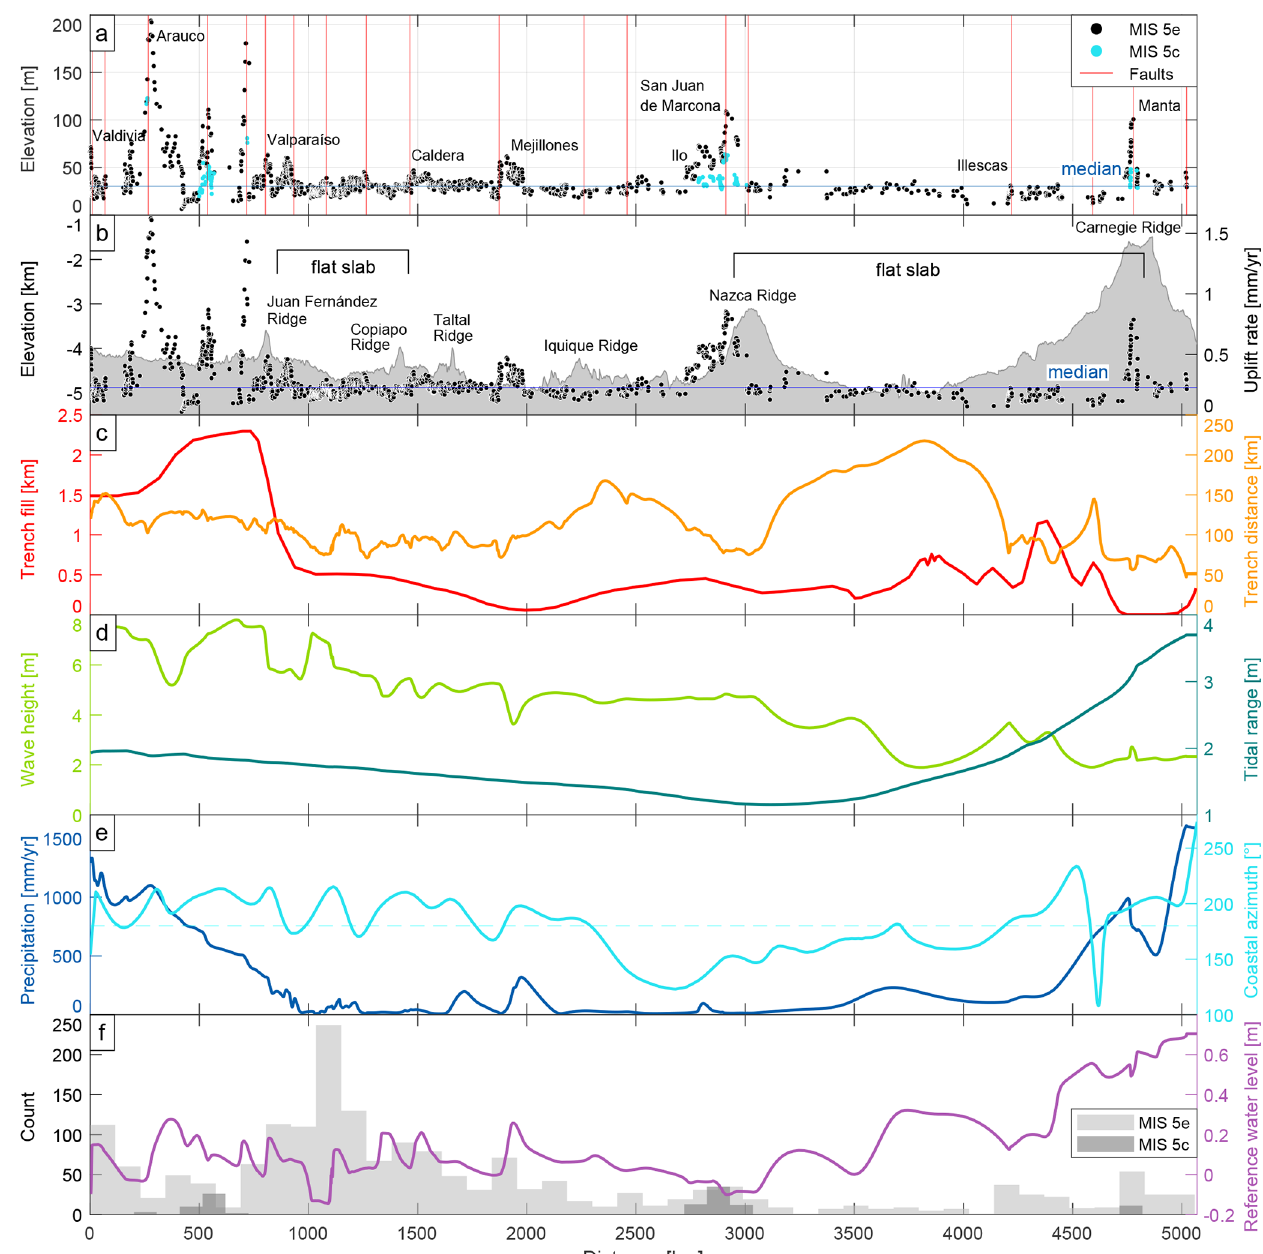
Figure 11. Terrace-elevation and uplift-rate estimates plotted in comparison with various parameters (i.e., bathymetry, trench fill, trench distance, wave height, tidal range, precipitation, and coastal azimuth) that might influence the disparate characteristics of the marine terrace distribution revealed by our data set. We projected these parameters, elevations, and uplift rates with respect to a south–north-oriented polyline that represents the trench. (a) Terrace-elevation measurements and the most important crustal faults (Veloza et al., 2012; Maldonado et al., 2021). This shows the range of altitudes in different regions along the coast and possible relationships between terrace elevation and crustal faulting. The blue horizontal line indicates the median elevation (30.1m). (b) Coastal uplift rates and mean bathymetry (GEBCO Bathymetric Compilation Group, 2020) of a 150km swath west of the trench. The blue horizontal line indicates the median uplift rate (0.22mmyr − 1 ). (c) Sediment thickness of trench-fill deposits (red) (Bangs and Cande, 1997) and the distance of the trench from our terrace measurements (orange). Flat-slab segments of the subducting Nazca plate are indicated for central Chile and Peru. (d) Maximum wave heights along the WSAC (light green) and the tidal range (dark green) between highest and lowest astronomical tides (Lorscheid and Rovere, 2019). (e) Precipitation (blue) along the WSAC (Ceccherini et al., 2015) and azimuthal orientation of the coastline (cyan). (f) Histogram of terrace-elevation measurements along the